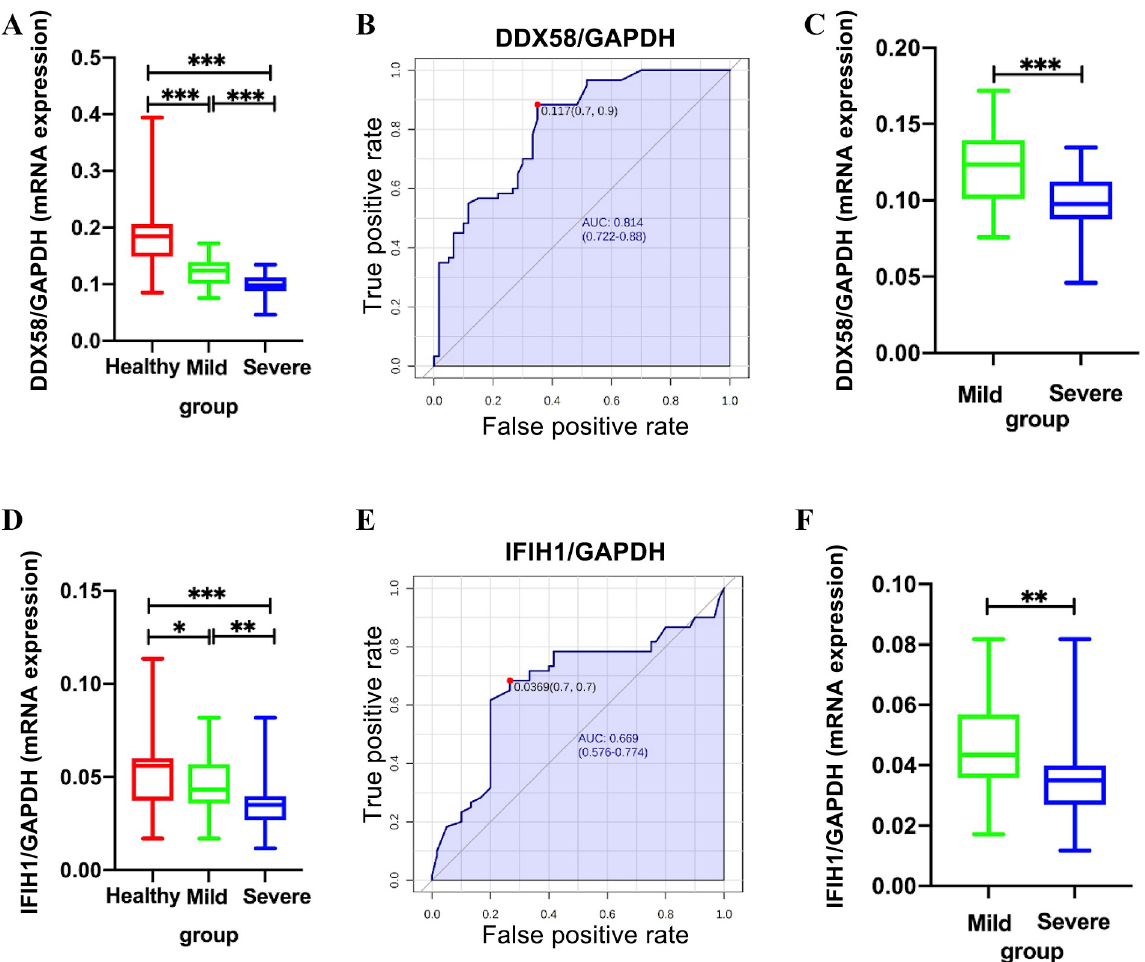
Fig 4. Determination of DDX58 mRNA expression in all samples (A). AUC of DDX58 mRNA levels between mild and severe EV71-HFMD patients (B). Determination of DDX58 mRNA expression between mild and severe EV71-HFMD patients (C). Determination of IFIH1 mRNA expression in all samples (D). AUC of IFIH1 mRNA levels between mild and severe EV71-HFMD patients (E). Determination of IFIH1 mRNA expression between mild and severe EV71-HFMD patients (F). ��� p <